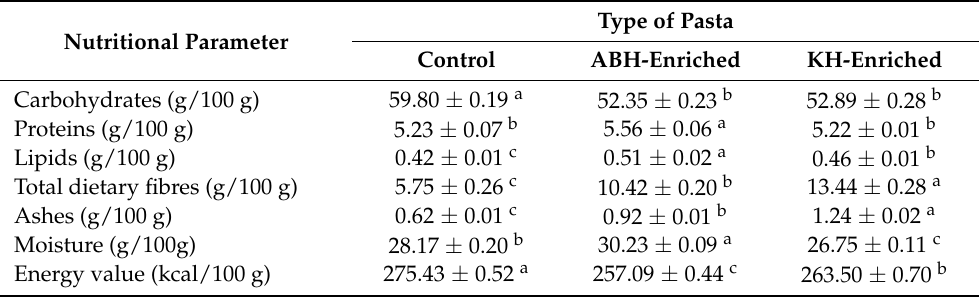
Table 2. Nutritional characteristics of GF fresh pasta enriched with 8 g/100g of Apulian black (ABH) or kabuli (KH) chickpea hull, compared to control pasta. All values (mean value ± standard deviation) are expressed on fresh weight basis. One-way ANOVA was applied. Nutritional